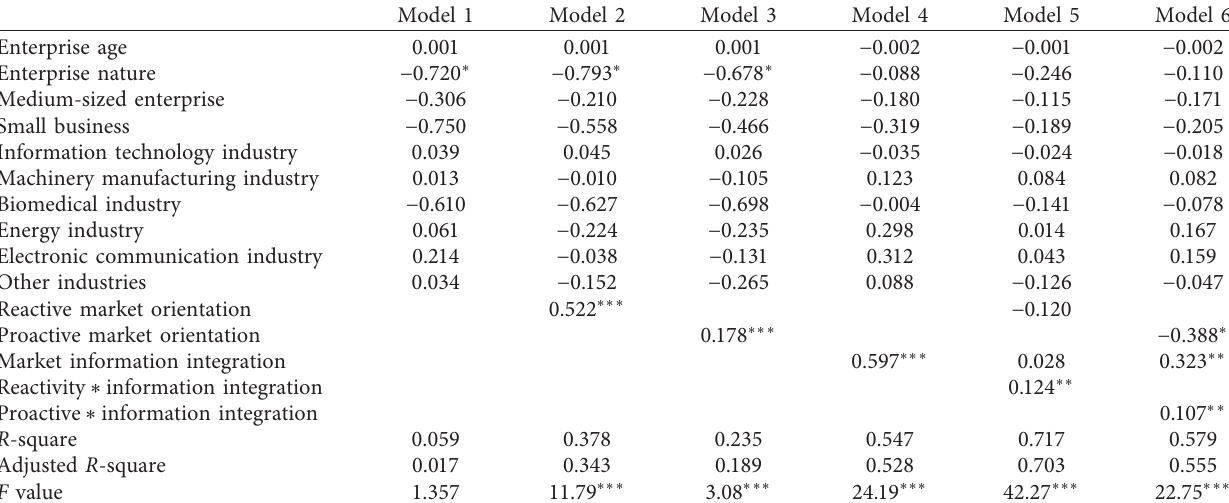
Table 2: Regression coefficient